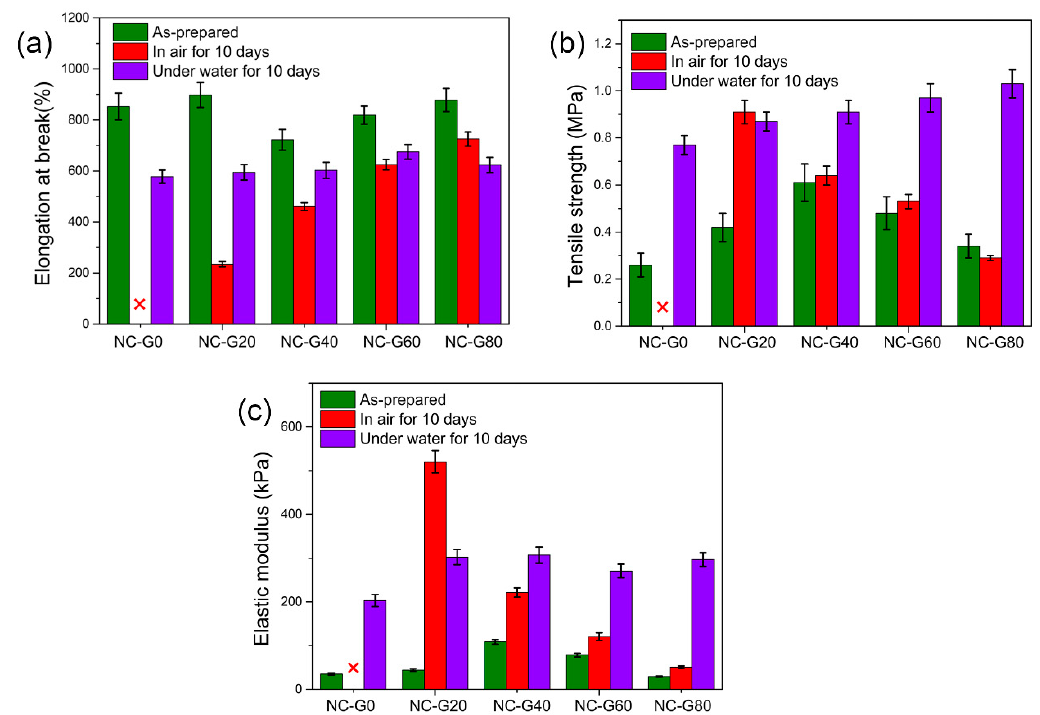
Figure 8. Comparison of mechanical properties of NC-G gels placed in air and under water for 10 days. ( a ) Elongation at break; ( b ) Tensile strength; ( c ) Elastic modulus.